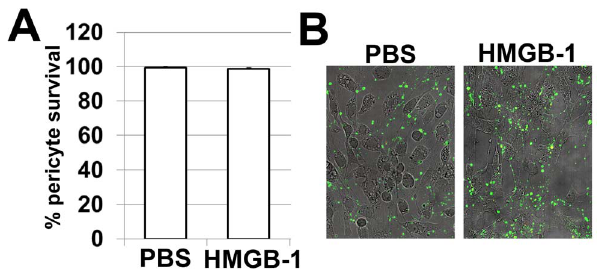
Figure 1. HMGB-1 does not directly mediate pericyte death. ( A ) Treatment with HMGB-1 (10 m g/ml) does not increase cell death in pure primary human pericyte cultures. All experiments were repeated at least three times. ( B ) Pericyte death was determined using annexin V as a marker of apoptotic cells and annexinV/propidium iodide (PI) to identify necrotic